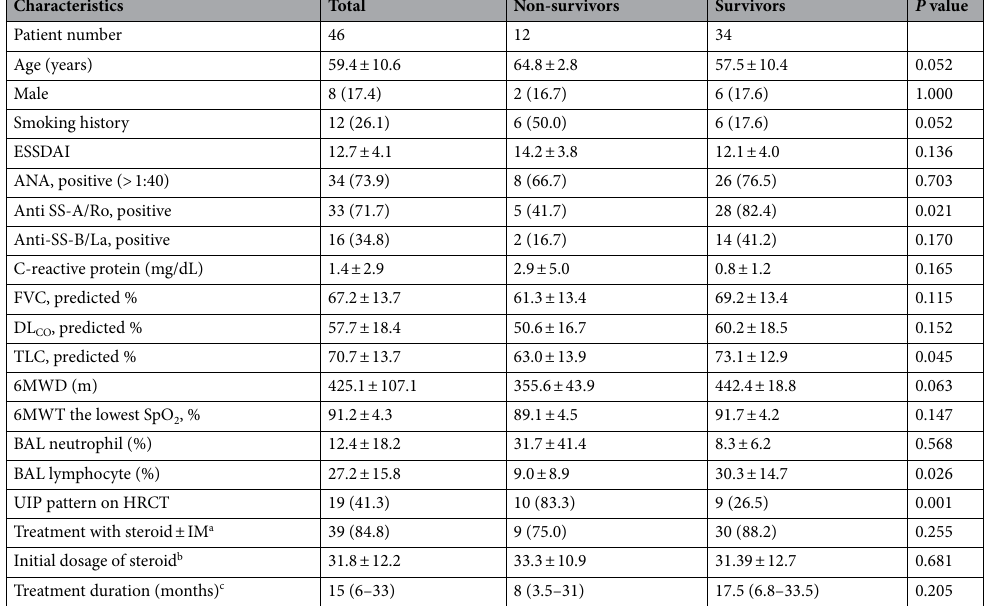
Table 1. Comparison between the baseline characteristics of non-survivors and survivors in patients with SJS-ILD. Data are presented as mean ± standard deviation or number (%), unless otherwise indicated. 6MWD six-minute walk test distance, 6MWT the lowest SpO2 lowest oxygen saturation during the six-minute walking test, ANA anti-nuclear antibody, BAL bronchoalveolar lavage, DL CO diffusing capacity of the lung for carbon monoxide, ESSDAI European Alliance of Associations for Rheumatology Sjögren’s Syndrome Disease Activity Index, FVC forced vital capacity, HRCT high resolution computed tomography, ILD interstitial lung disease, IM immunosuppressants, SJS Sjögren syndrome, TLC total lung capacity, UIP usual interstitial pneumonia. a The immunosuppressants included azathioprine (n = 20), cyclosporine (n = 16), mycophenolate mofetil (n = 21), and cyclophosphamide (n = 6). b Prednisolone equivalent dose. c Median (interquartile range).